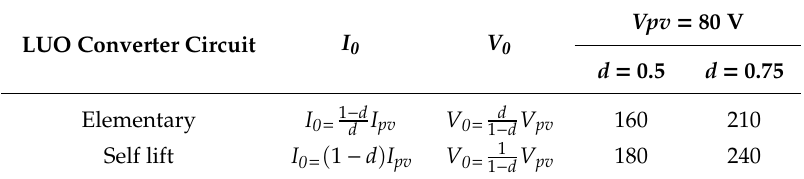
Table 3. Proposed Luo converter output voltage gain comparison with different Luo converter structures. Table3. ProposedLuoconverteroutputvoltagegaincomparisonwithdi ff